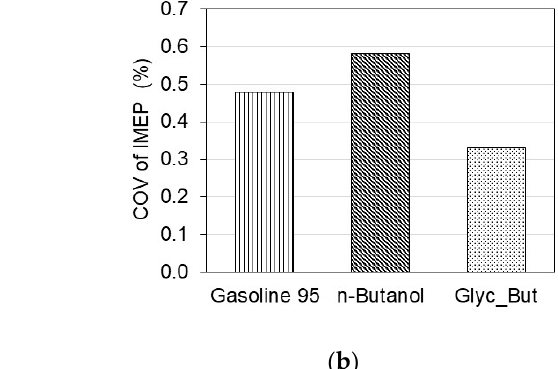
Figure 6. ( a ) Indicated mean effective pressure (IMEP); ( b ) COV of IMEP for the tested fuels at optimal spark timings. One of the important indicators of engine operation is the COV of IMEP. As mentioned, it expresses the smoothness of engine run. The maximum acceptable limit of the COV of IMEP is 5% for stationary engines working in power generation units. As shown in Figure 6b, the COV of IMEP for all these three tests was significantly below 5%, which indicates good, even excellent, smoothness of engine run. The last analyzed parameter in this section is the indicated efficiency of the engine, as plotted in Figure 7.